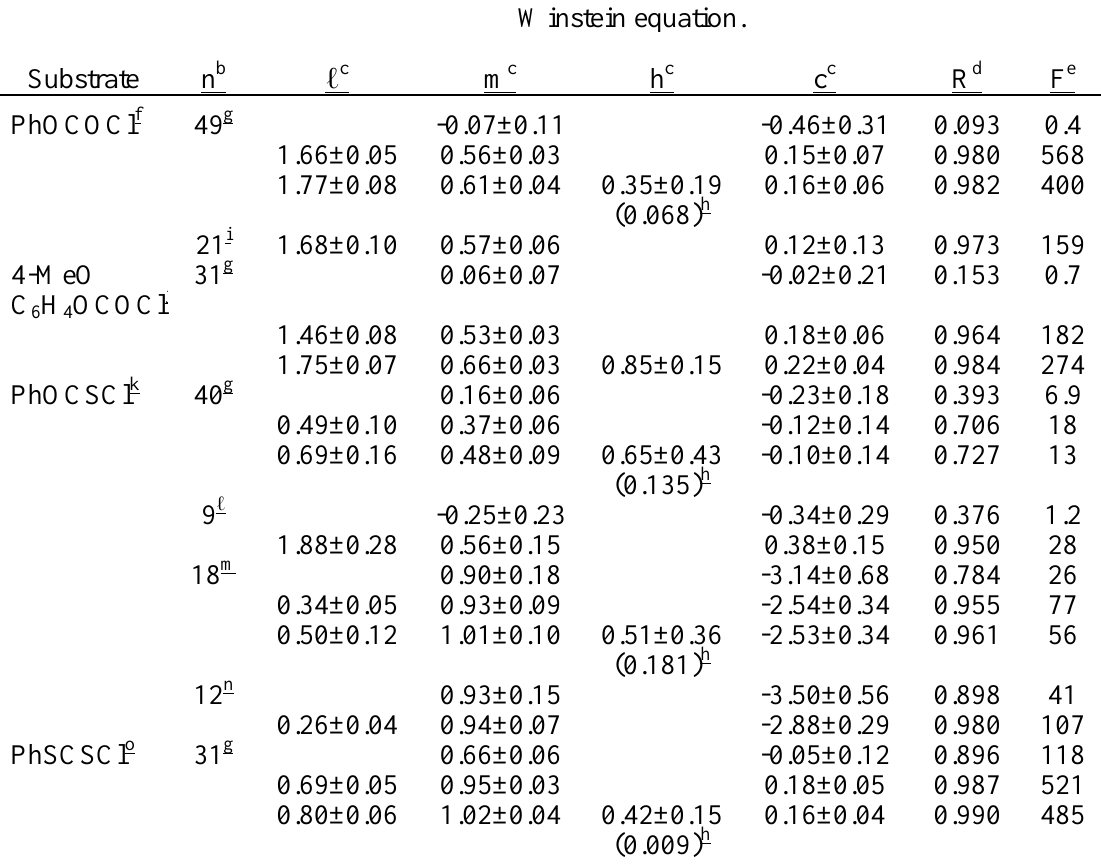
Table 3 . Correlation a of the rates of solvolysis of phenyl chloroformate, its p-methoxy derivative, and the thiono and dithio derivatives, at 25.0ºC, using the original and extended forms of the Grunwald- Winstein